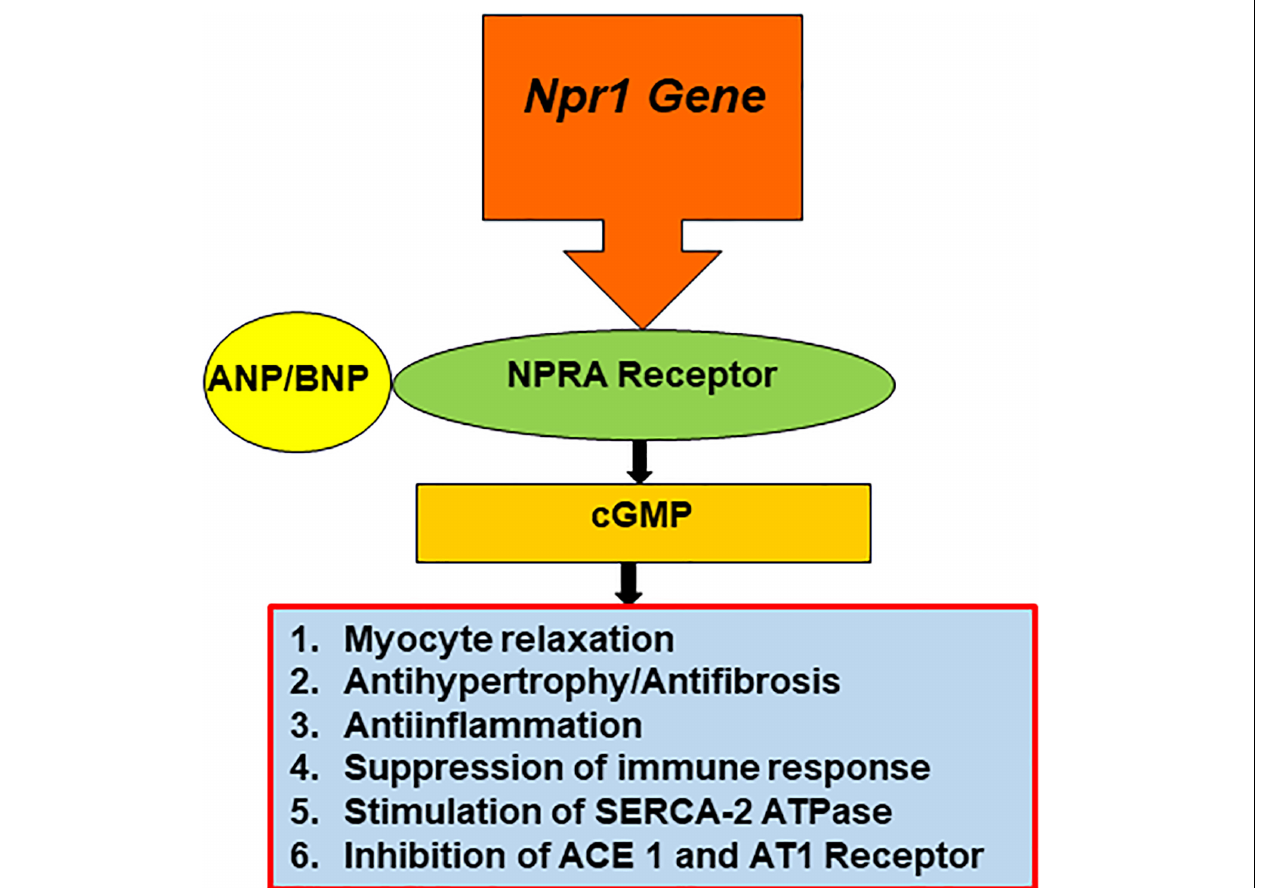
FIGURE 2 | The schematic representation of the NP-dependent activation and signaling of ANP/NPRA in the heart. To maintain the cardiac homeostasis, Npr1 gene is transcribed and translated to produce mature NPRA protein. Specifically, NPRA is activated by ANP and BNP; in turn produces intracellular second messenger cGMP that activates various physiological responsiveness in the heart tissues and